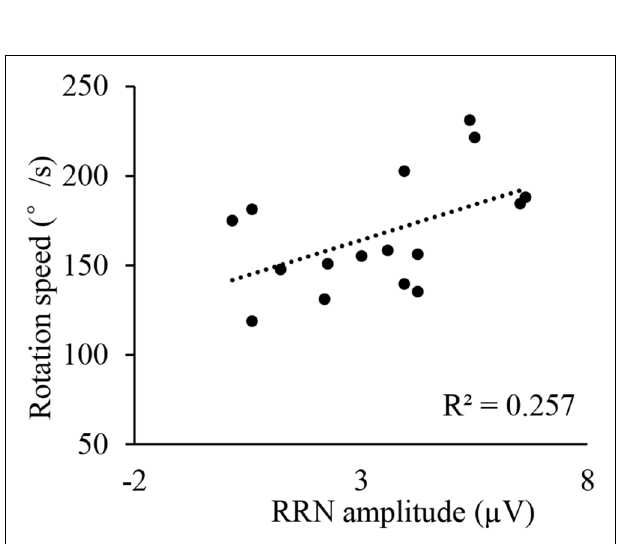
FIGURE 7 | Correlation between N2 amplitude (Pz) and RT at 0 ◦ for athletes in ET condition.